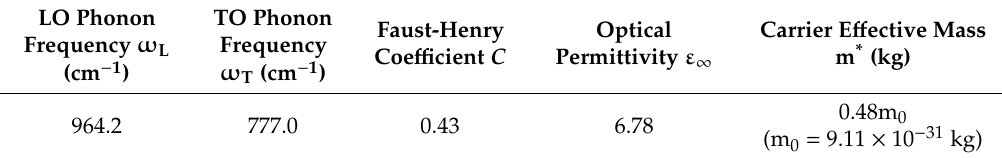
Table 2. The material constants used to fit experimental Raman spectroscopy